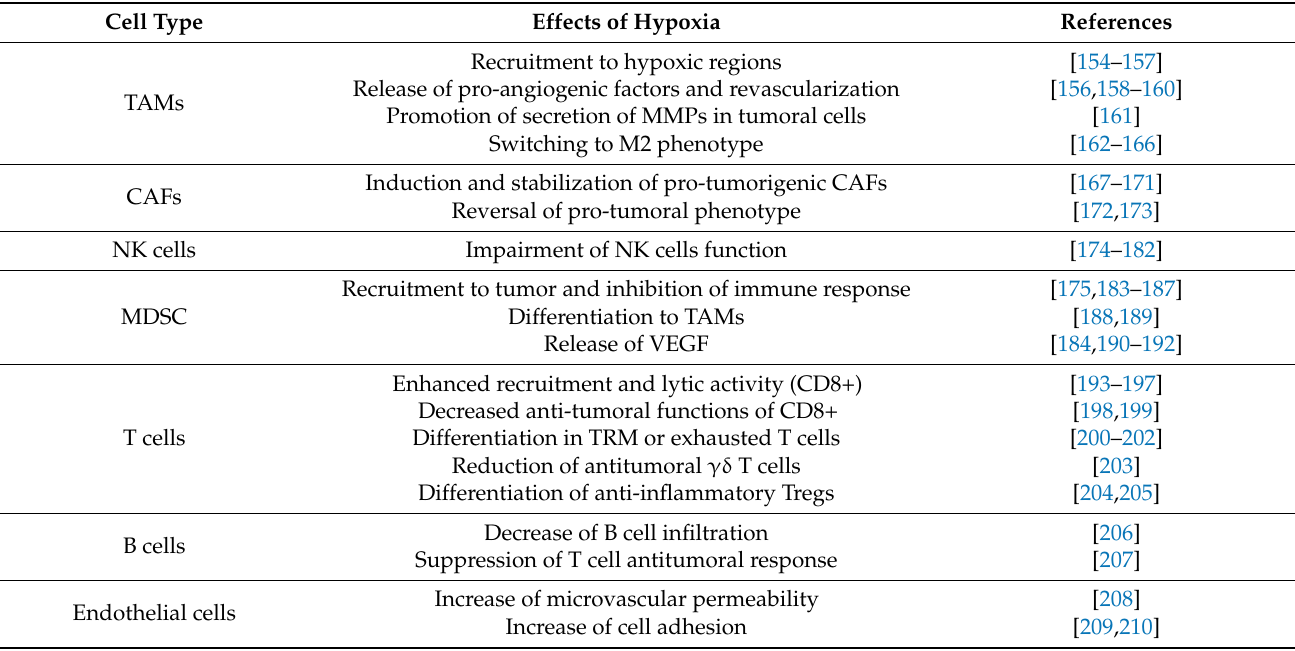
Table 1. Effects of hypoxia over cellular components of immune